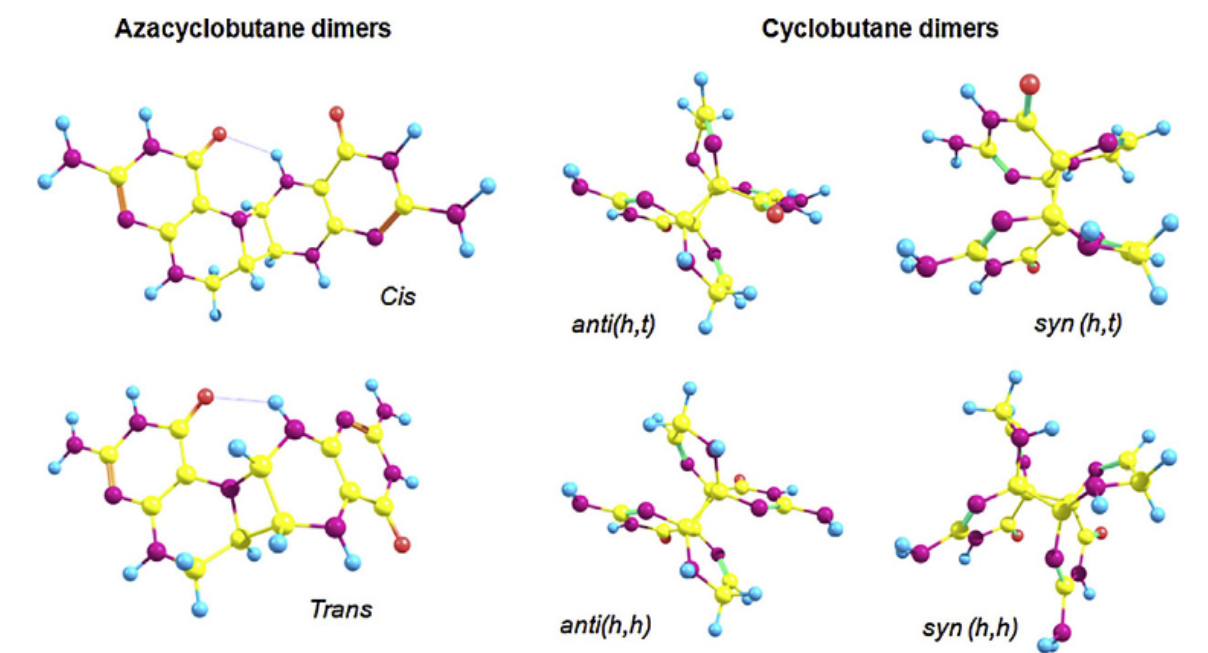
Figure 12. Cyclobutane and azacyclobutane isomers of (H 2 Ptr) 2 [29]. © 2022 Elsevier.